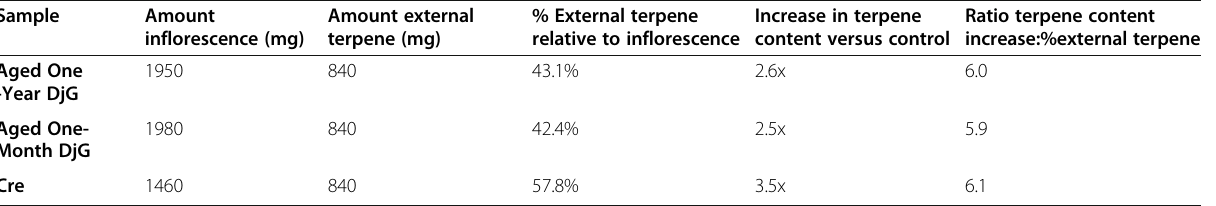
Table 3 Summary of the terpene content increase for preservation samples utilizing 1 mL (840 mg) of external volatile Sample